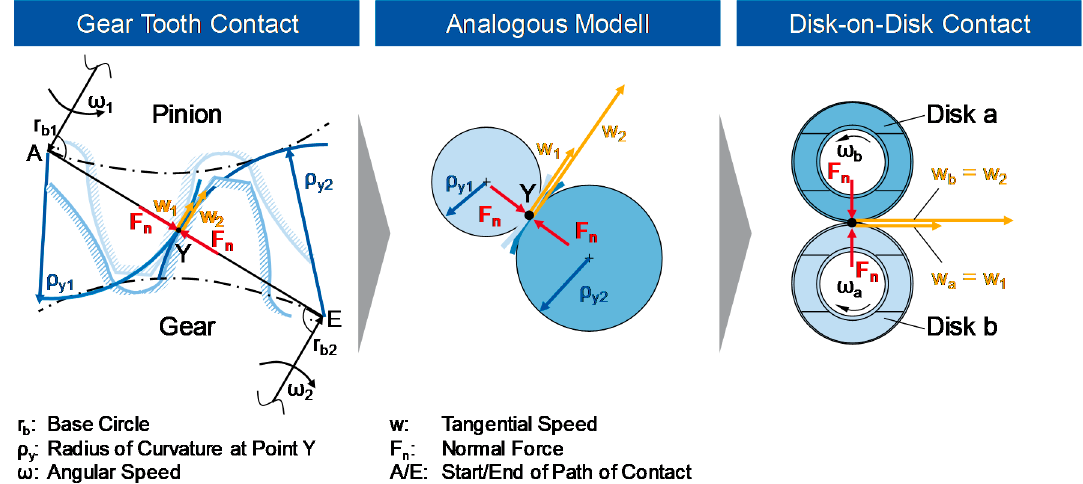
Figure 4. Transfer of the gear test to the disk-on-disk test.